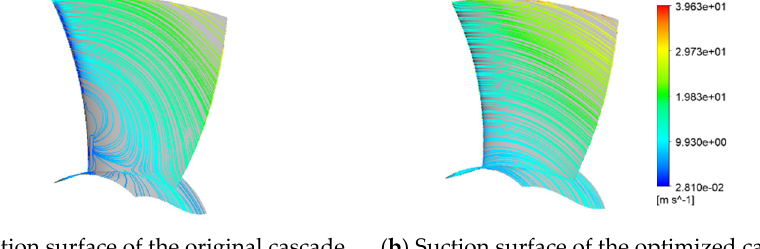
Figure 17. Surface streamline comparisons of Blade D500.